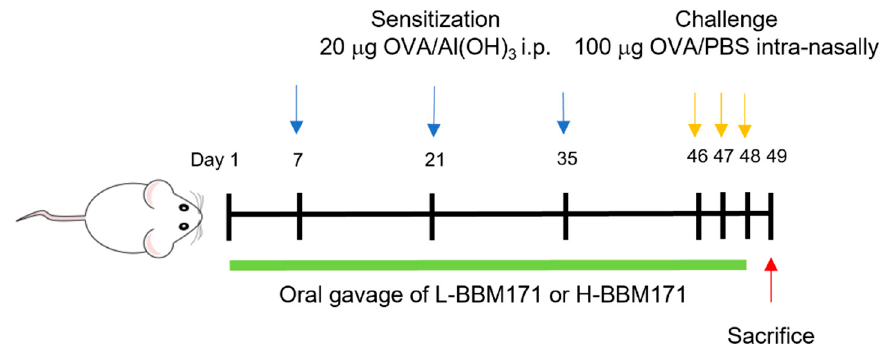
Figure 1. Experimental procedure of ovalbumin (OVA)-induced allergic mouse model. Female BALB/c mice were orally administered live L. paragasseri BBM171 (L-BBM171) or heat-inactivated L. paragasseri BBM171 (H-BBM171) by gavage for 48 days and injected with 20 µg OVA/Al(OH) 3 intra- peritoneally on days 7, 21, and 35. On days 46, 47, and 48, mice were challenged with 100 µg OVA/PBS by intranasal administration.